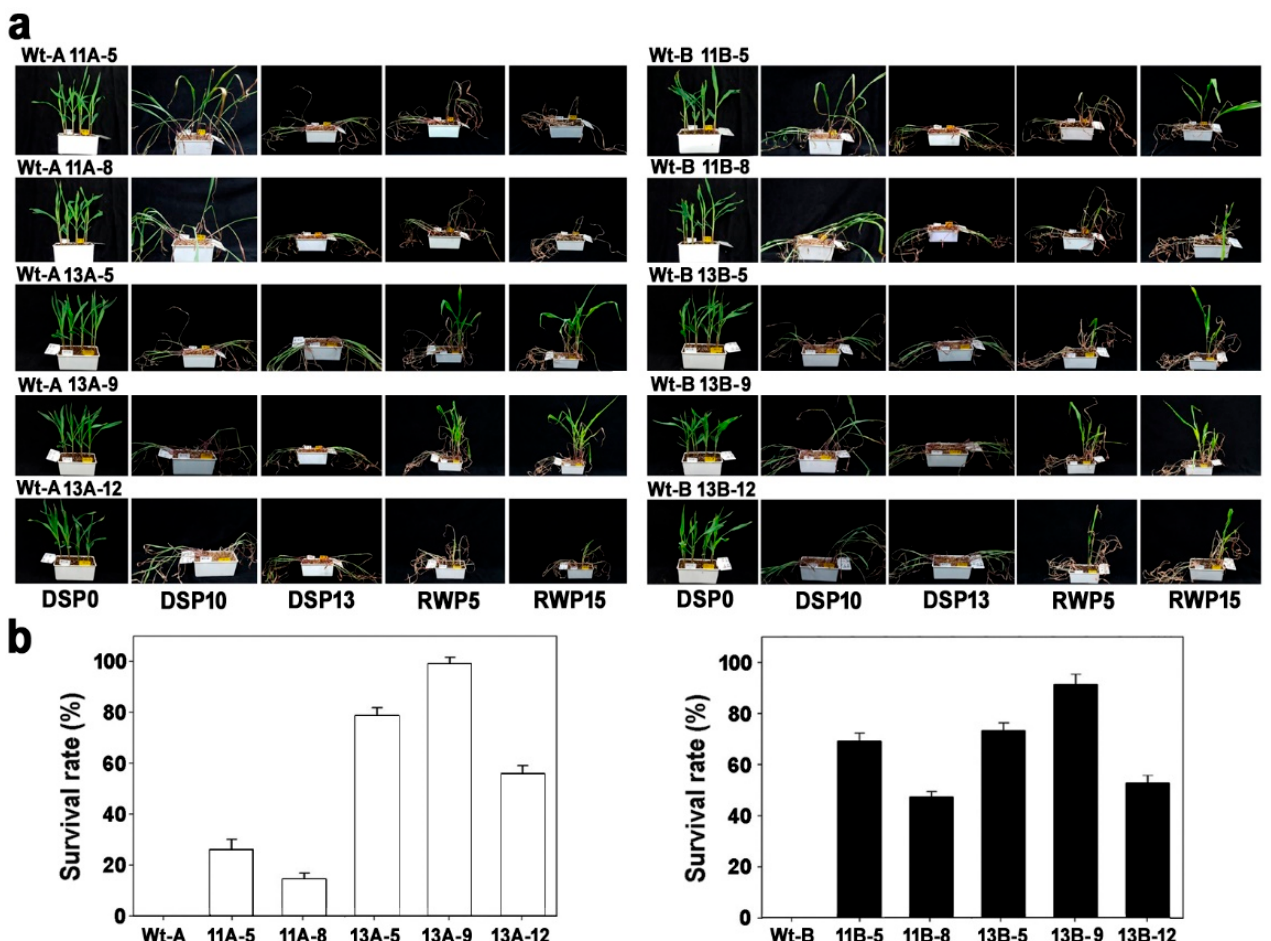
Figure 2. Tolerance of OsPYL / RCAR7 -OX maize seedlings to drought stress. ( a ) Seedlings grown of transgenic maize under drought-stress conditions. ( b ) Survival rate after drought stress. Survival rate was calculated by counting the surviving seedlings in each pot. Bars represent the means ± SE of three replicates. DSP, drought-stress phase; RWP, rewatering phase; Wt, untransformed wild-type plants; and 11A-5 to 13B-12, selected transgenic lines.